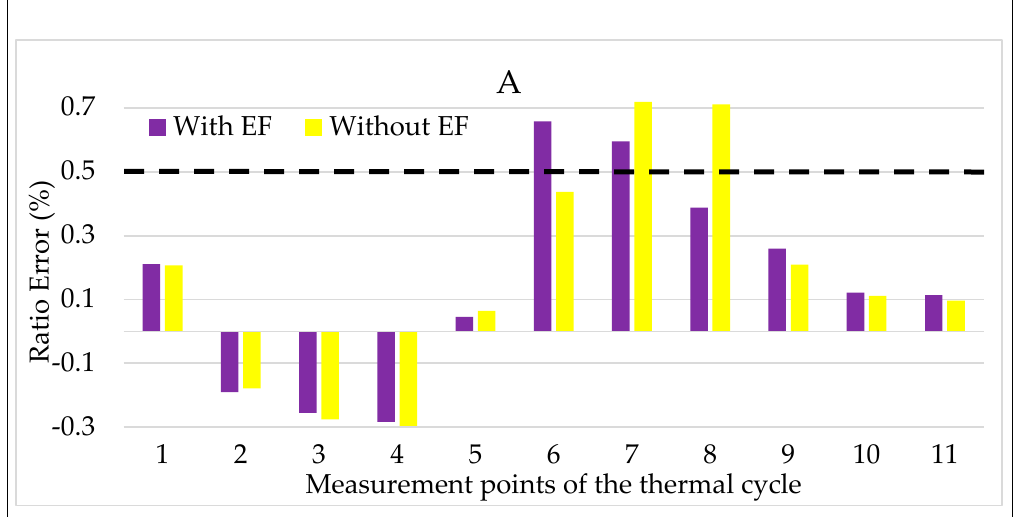
Figure 13. Ratio error vs. temperature + electric field for LPVT A.